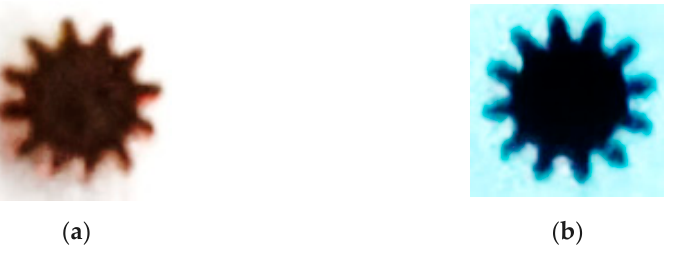
Figure 11. micrograph of formed gear and die. ( a ) Micro gear parts formed by machining, ( b ) Par- tial screenshot of die gear teeth